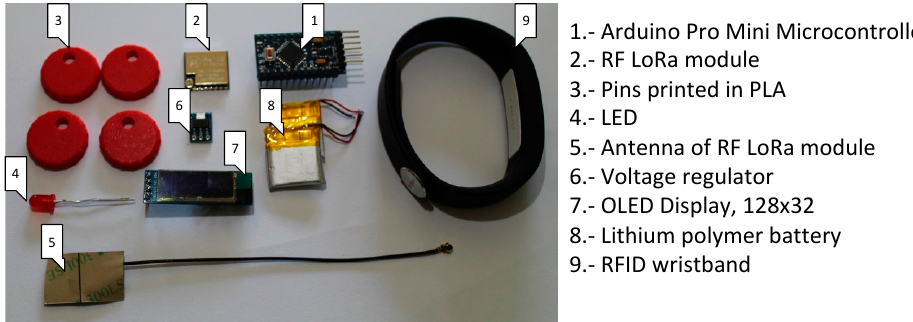
Figure 3. Components to use for implementing a physical prototype of HELPi digital bracelet.